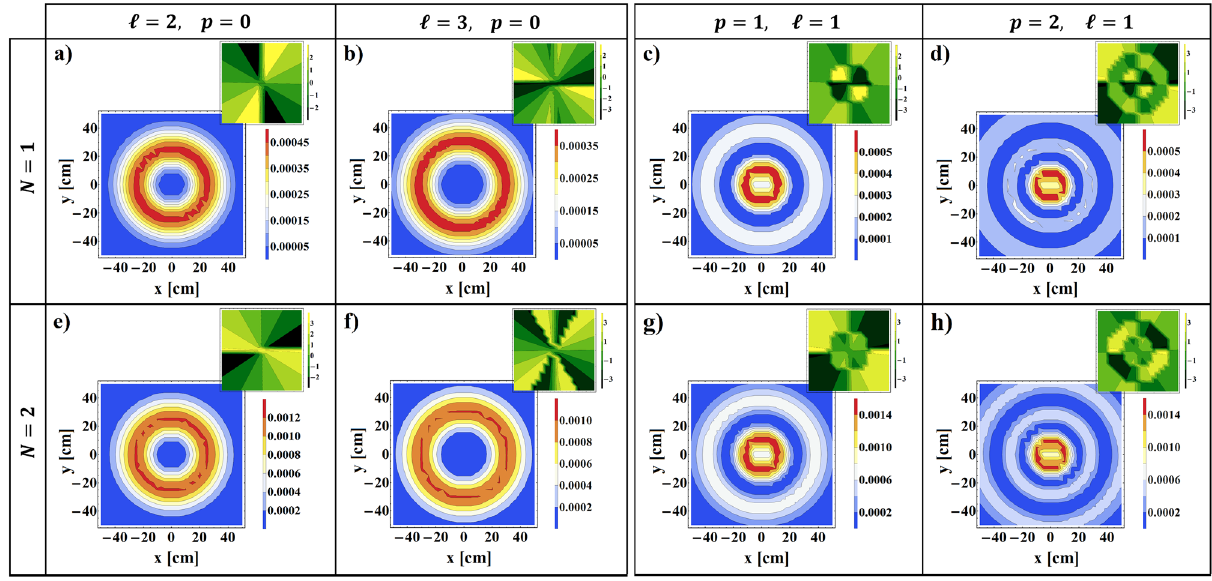
3 10 11 cm , − = 1 (upper row), =